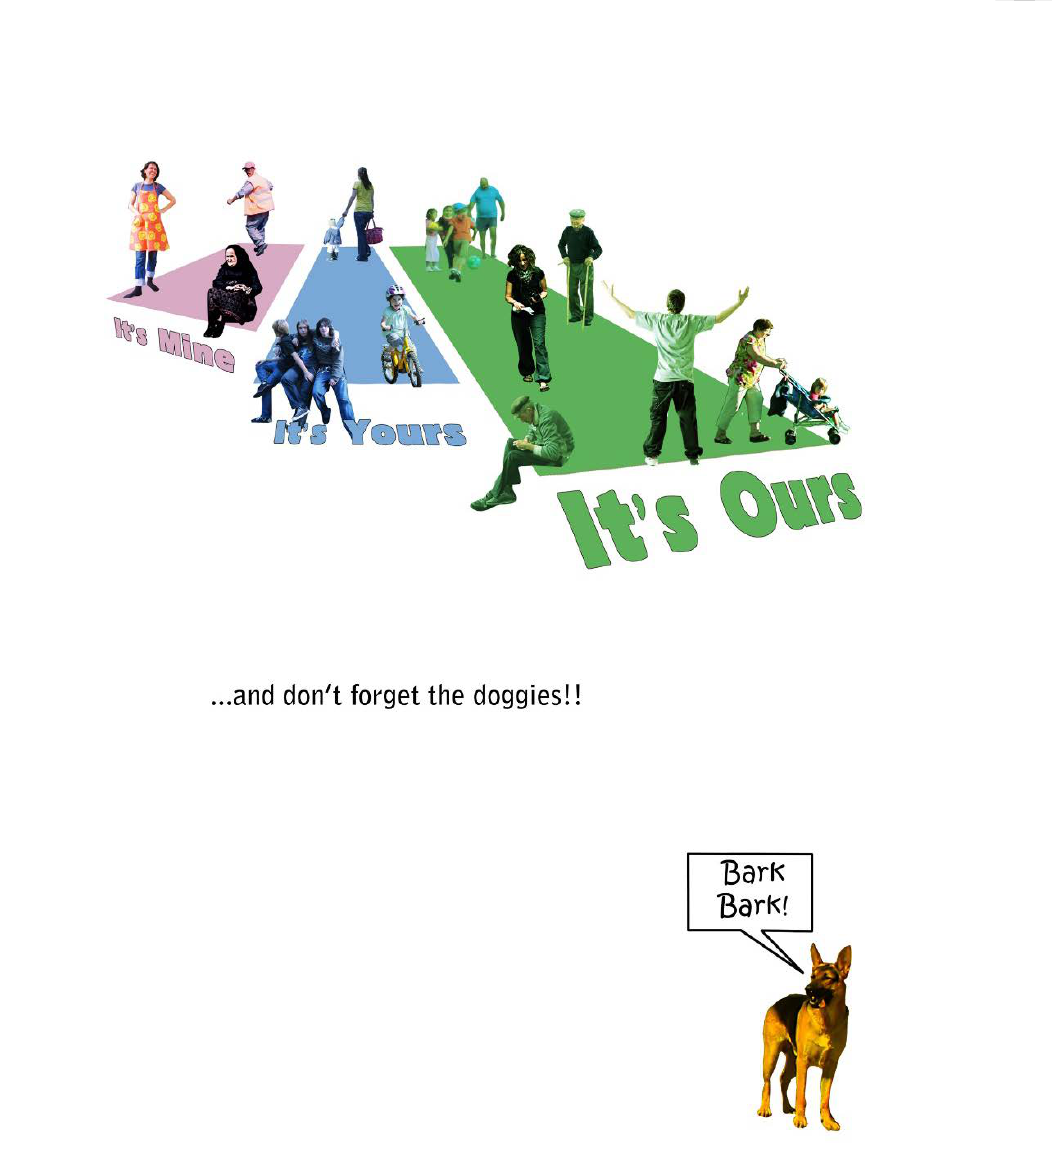
Figure 17: Slogans from the 2012 final presentation